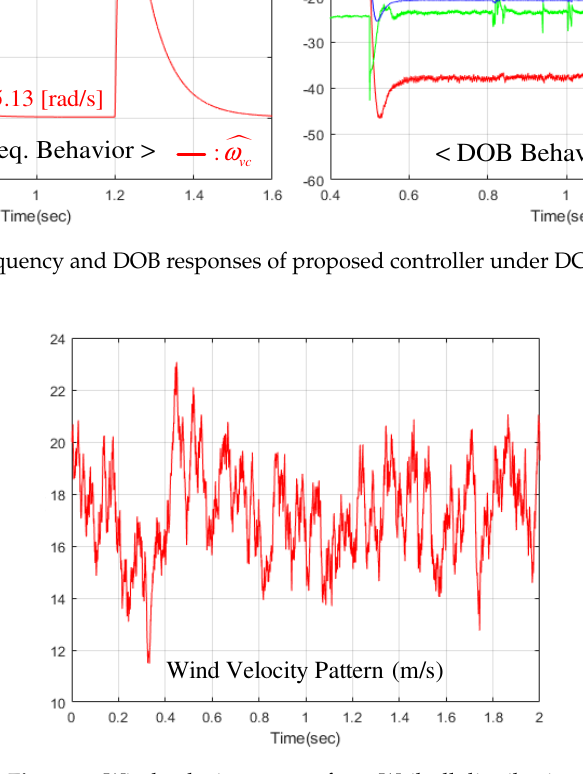
Figure 6. Wind velocity pattern from Weibull